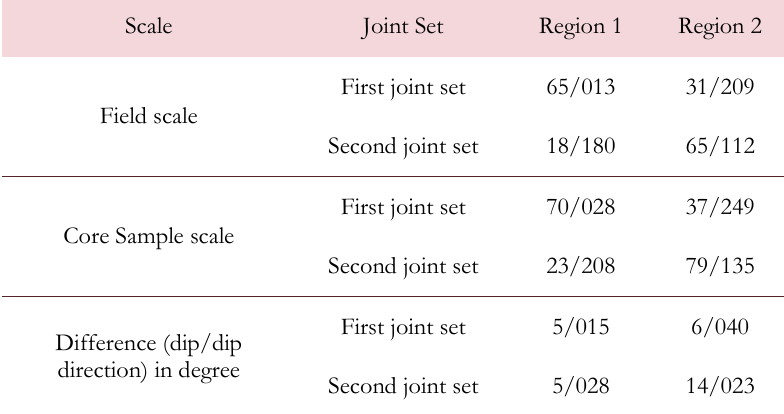
Table 2: Dip/Dip direction for two studied areas in two different